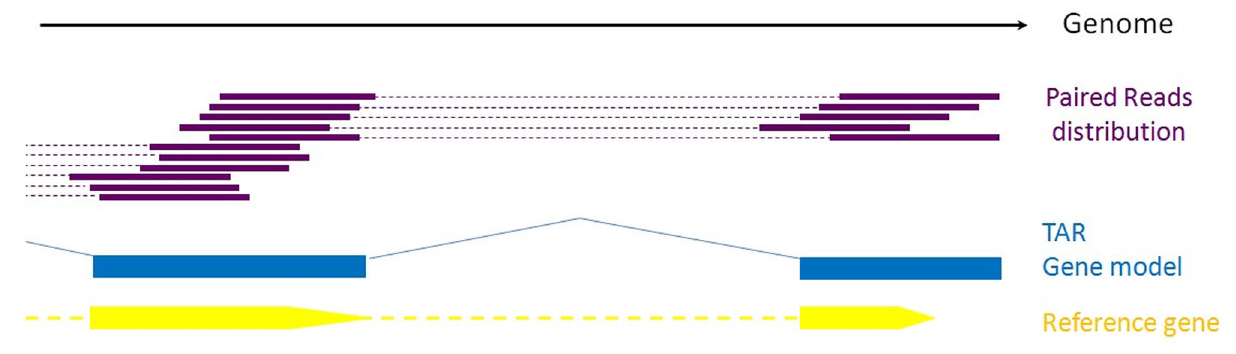
Figure 2. Gene boundary-refining algorithm sketch. This diagram illustrates the gene extension process. Purple lines indicate the continuous and overlapping regions of sequence similarity between paired sequencing reads and the genome. The blue thick lines denote transcriptionally active regions (TARs) identified by overlapping reads. Different TARs were connected using the thin blue lines to form potential gene models. Through comparisons of the existing yellow reference gene with the gene model, the annotated gene could be extended at the 5’ end, the 3’ end or at both